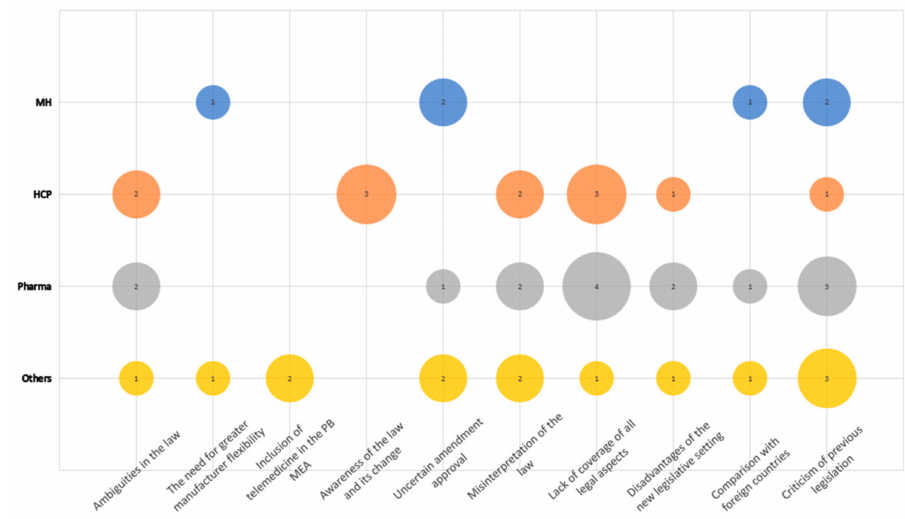
Figure 2. Legislation: frequency chart of codes in defined sub-categories within the category legisla- tion by occupational group.